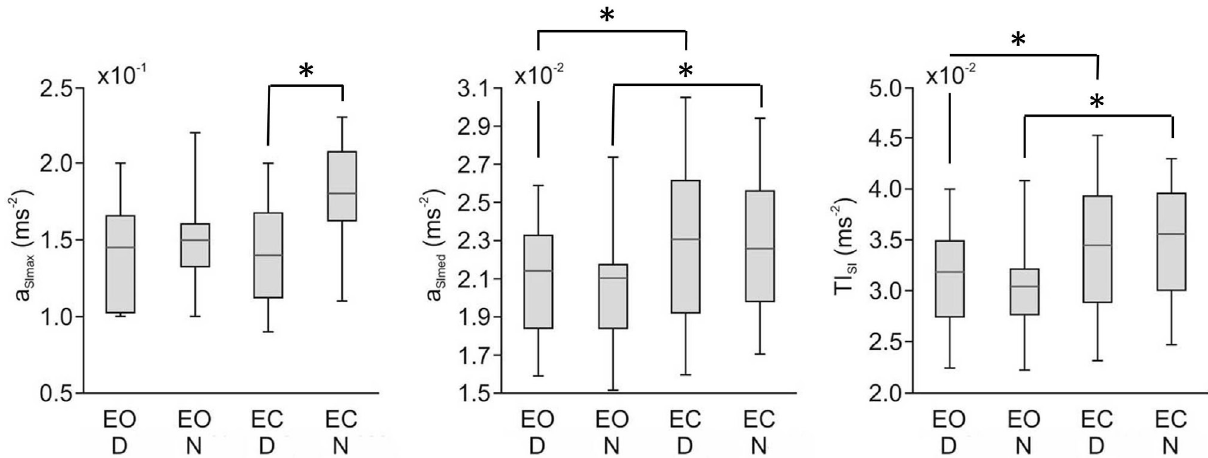
Figure 3. Comparison of maximum (max) and median (med) superior-inferior accelerations and tremor intensity (TI) of superior-inferior acceleration of dominant (D) and non-dominant (N) upper arms of subjects standing with eyes open (EO) and eyes closed (EC). *statistically significant